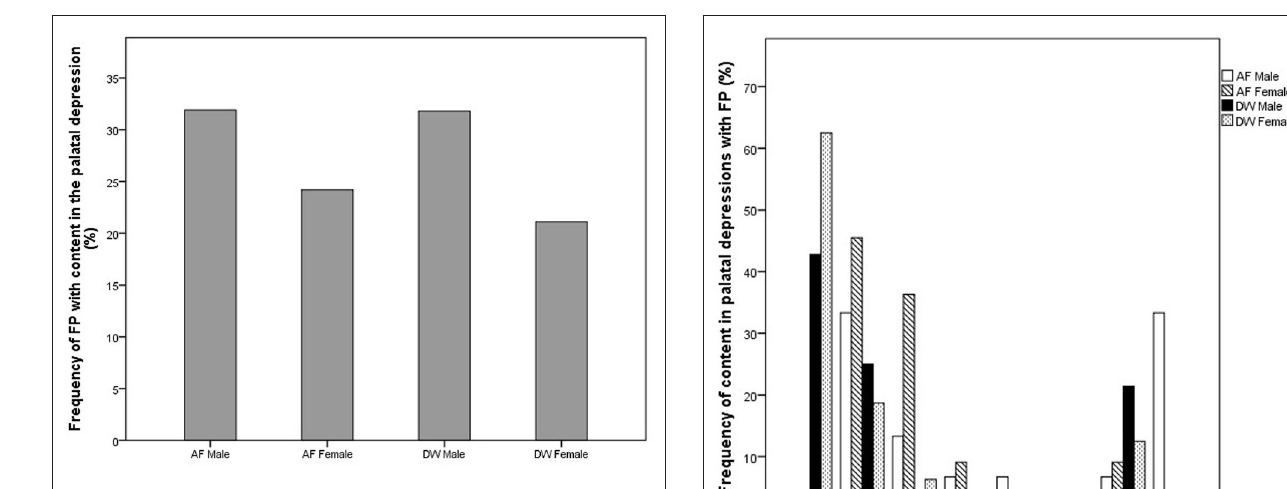
Table 3 . Keeping other variables constant, FP is